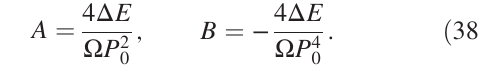
), and equatorial anions ( d ); energy O 1 O 2 ; 3